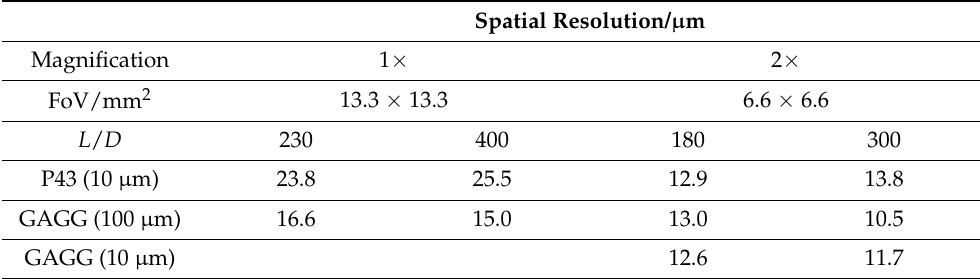
Figure 3. Neutron transmission images taken at 1 × magnification condition with L / D = 400. ( a ) An image taken with P43 (10 µ m), ( b ) an image taken with GAGG (100 µ m). ( c ) and ( d ) are enlarged images of ( a ) and ( b ), respectively. Table 1. Summary of the spatial resolution of neutron radiography of the Siemens star test